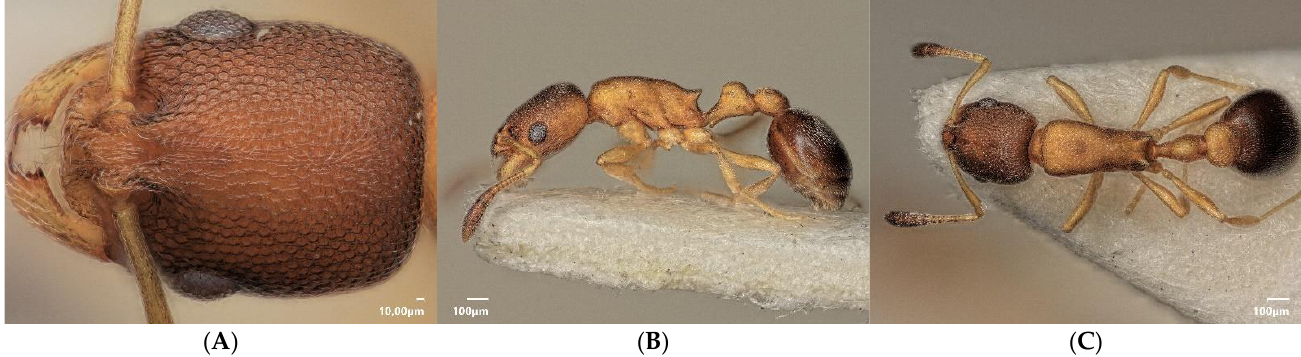
Figure 2. Cardiocondyla minutior : head in dorsal view ( A ), lateral view ( B ), dorsal view ( C ).